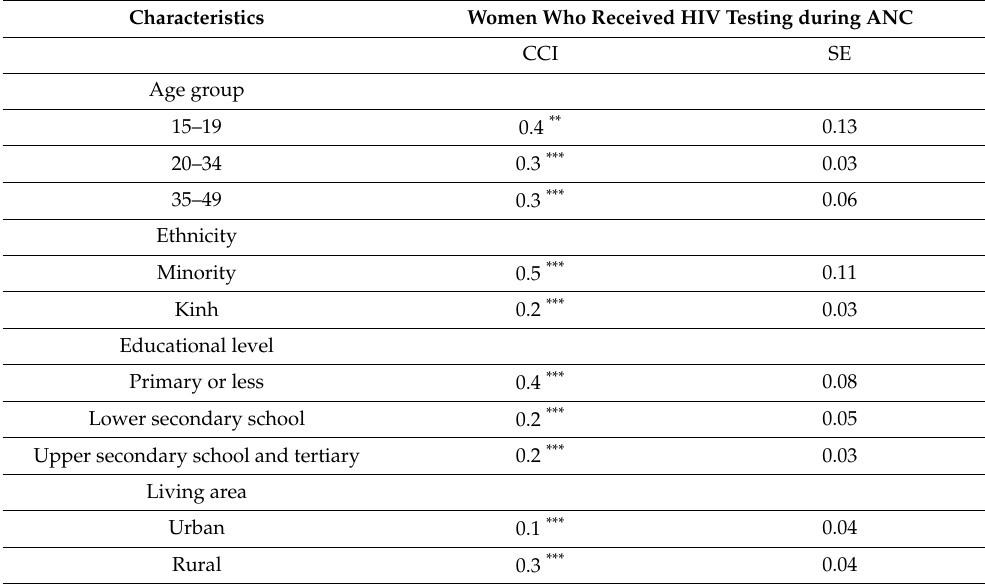
Table 3. Concentration indices of HIV testing during antenatal care among women aged 15–49 years who had a live birth in the last two years by socioeconomic